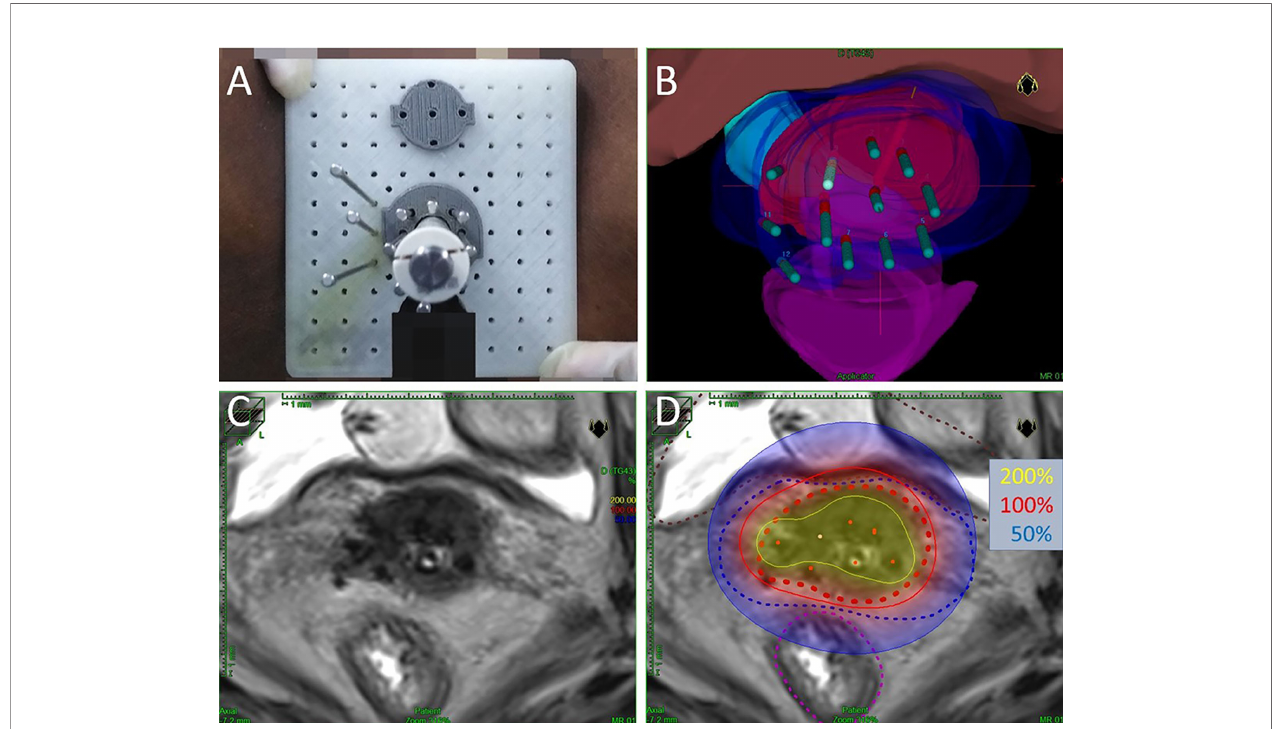
FIGURE 2 | (A) Macroscopic view of self-made 3D-Printed applicator. (B) Three-dimensional view of the same implant planning data. The volumes represent HR- CTV (red), IR-CTV (blue), bladder (pink), rectum (purple), and sigmoid (cyan). (C) Axial view of T2-weighted magnetic resonance images (with implant in situ ). (D) Axial view of brachytherapy dose distribution. Dotted red line is HR-CTV, dotted blue line is IR-CTV, dotted brown line represents the bladder, and dotted purple line represents the rectum. The isodose lines color code conventions are: solid yellow line = 200%; solid red line = 100%; solid blue line = 50% per treatment fraction.